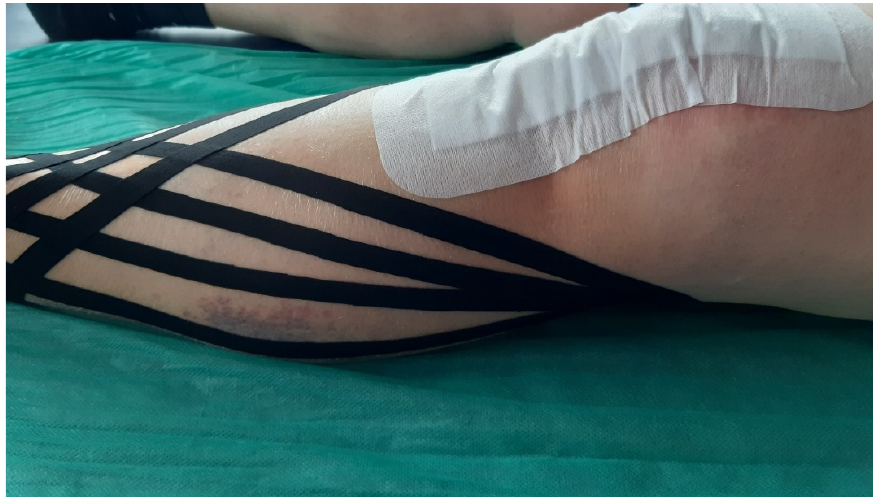
Figure 2. KT Lymphatic application on the lower leg.